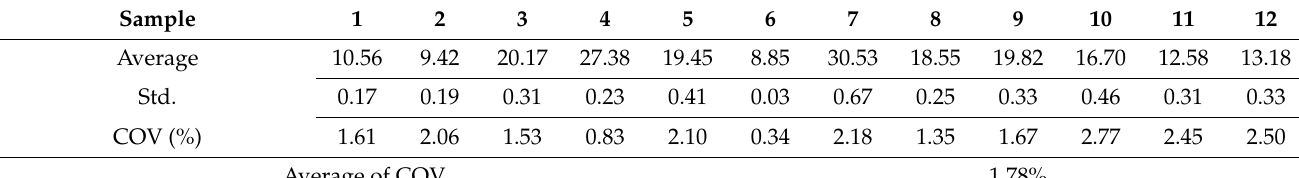
Figure 11. Concentration profiles of one concrete sample after scanning one side three times. Table 5. The diffusion coefficient of 12 concrete samples tested three times from the same side (D ac × 10 − 12 m 2